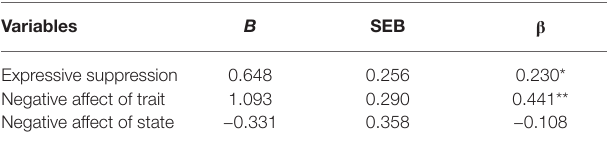
TABLE 7 | Standard regression analysis summary for healthy individuals’ variables predicting emotion dysregulation.